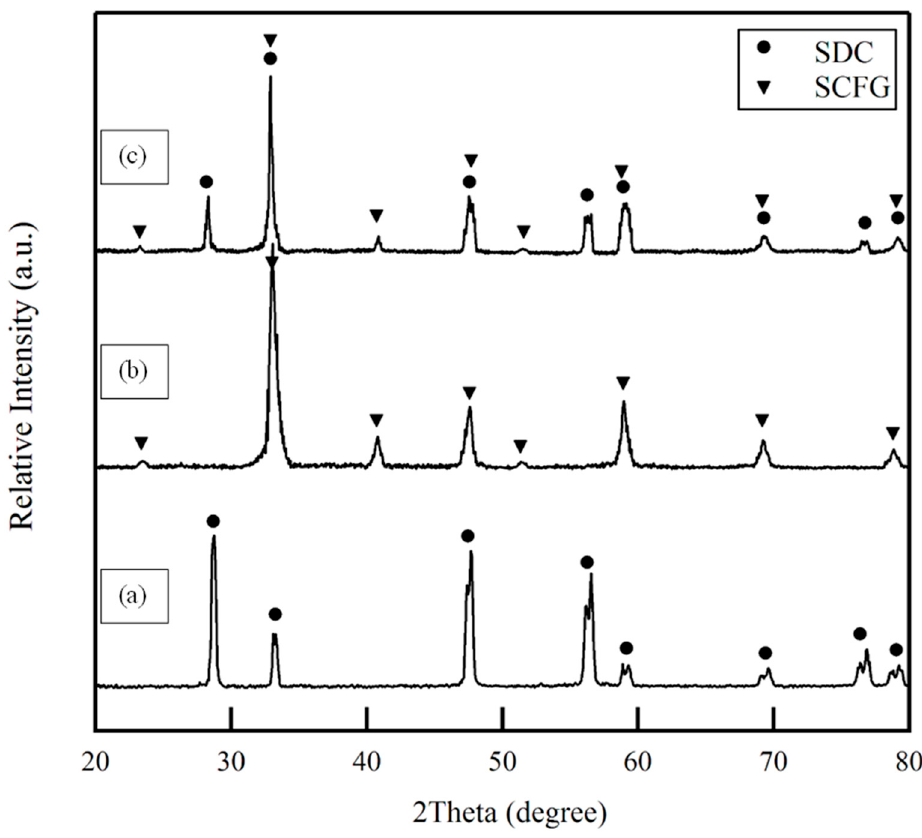
Figure 2. X-ray diffraction pattern of ( a ) SDC electrolyte powder calcined at 1200 °C for 5 h; ( b ) SCFG fibers calcined at 950 °C for 5 h; ( c ) SDC-infiltrated SCFG calcined at 1000 °C for 1 h.